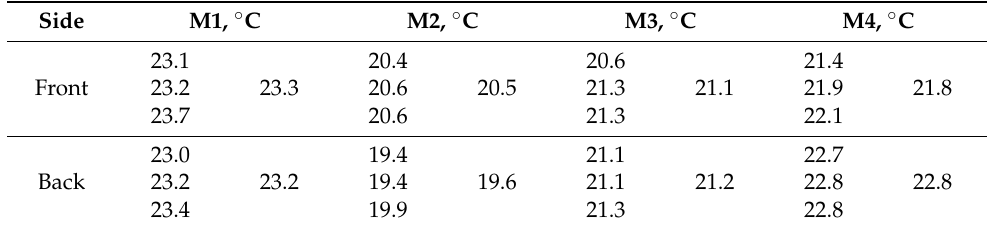
Table 1. The results of minimum temperature measurements on the surface of briquettes after briquetting.